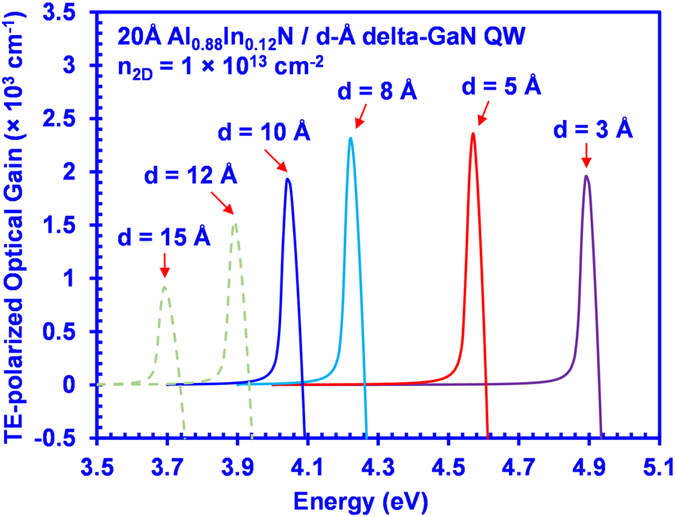
TE peak material gains (gTEpeak) spectra for 20 Å AlInN/d-Å delta-GaN QW with AlN barriers at n2D = 1 × 1013 cm−2.